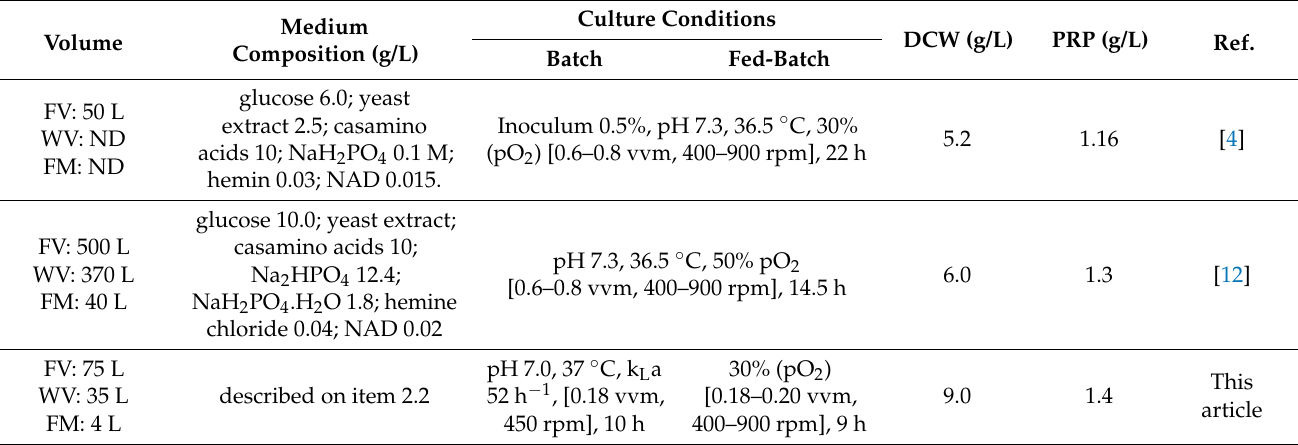
Table 5. Previous studies in pilot and large scale-up processes, conditions and production ( DCW and PRP ) by H. influenzae using bioreactor